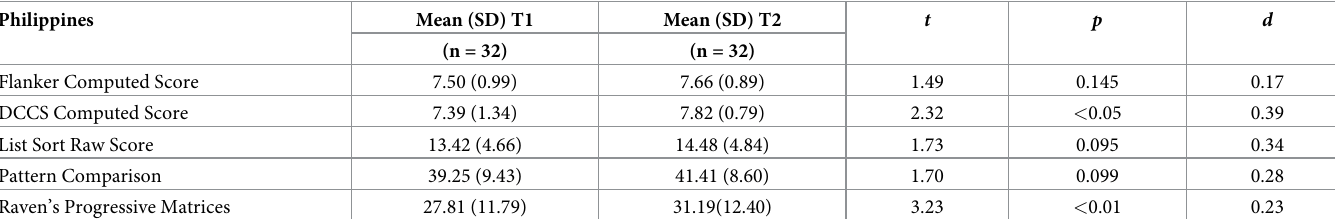
Table 6. Mean (SD) for assessment scores over time for Philippines.